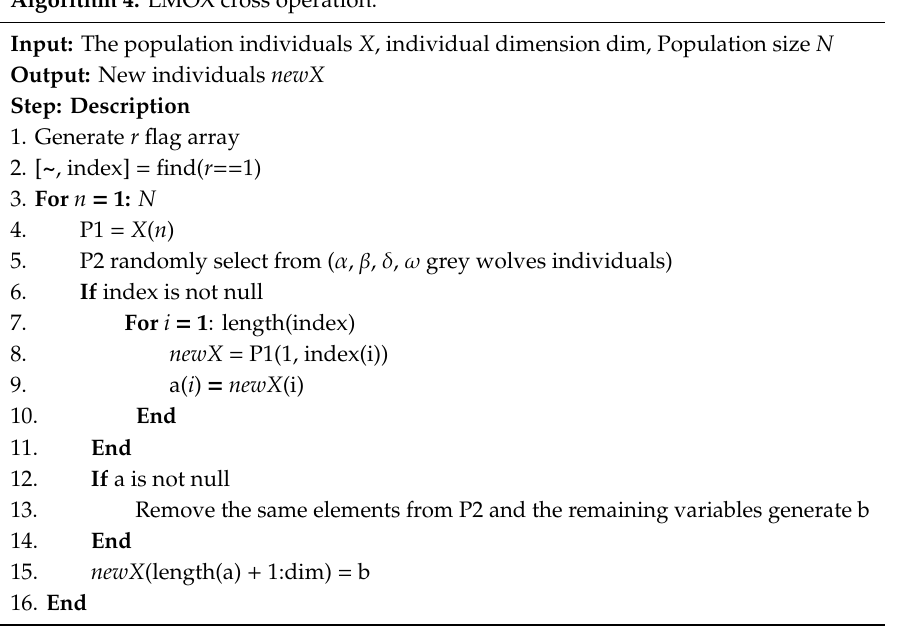
Algorithm 4. LMOX cross operation.